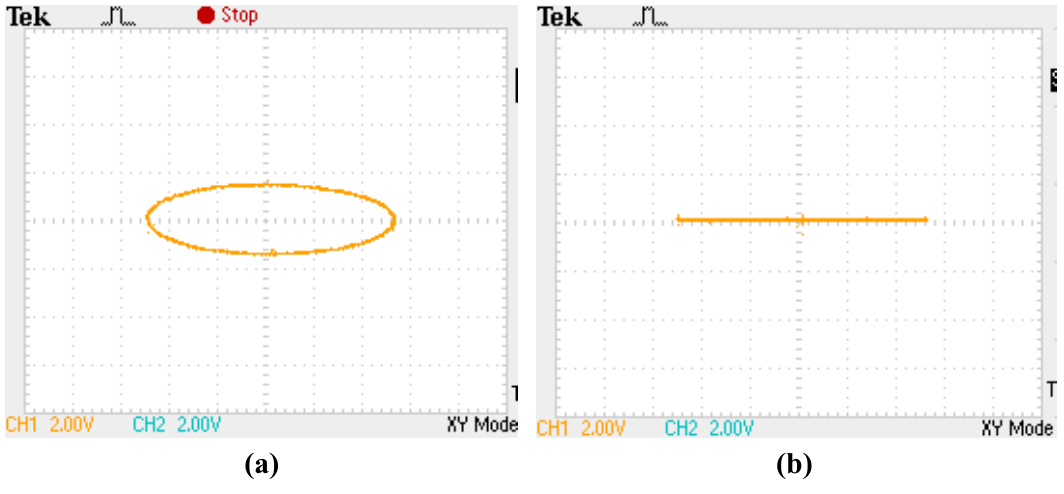
Figure 2. Lissajous figure on two electrodes with an angle distance by 45°. (a) An ellipse existing quadrature error. (b) A straight with the quadrature error